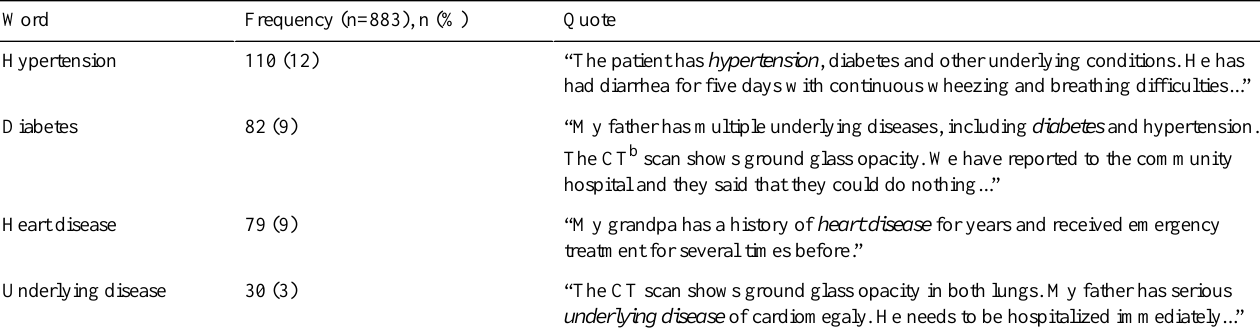
Table 4. Document frequency of terms indicating patients’underlying condition. a